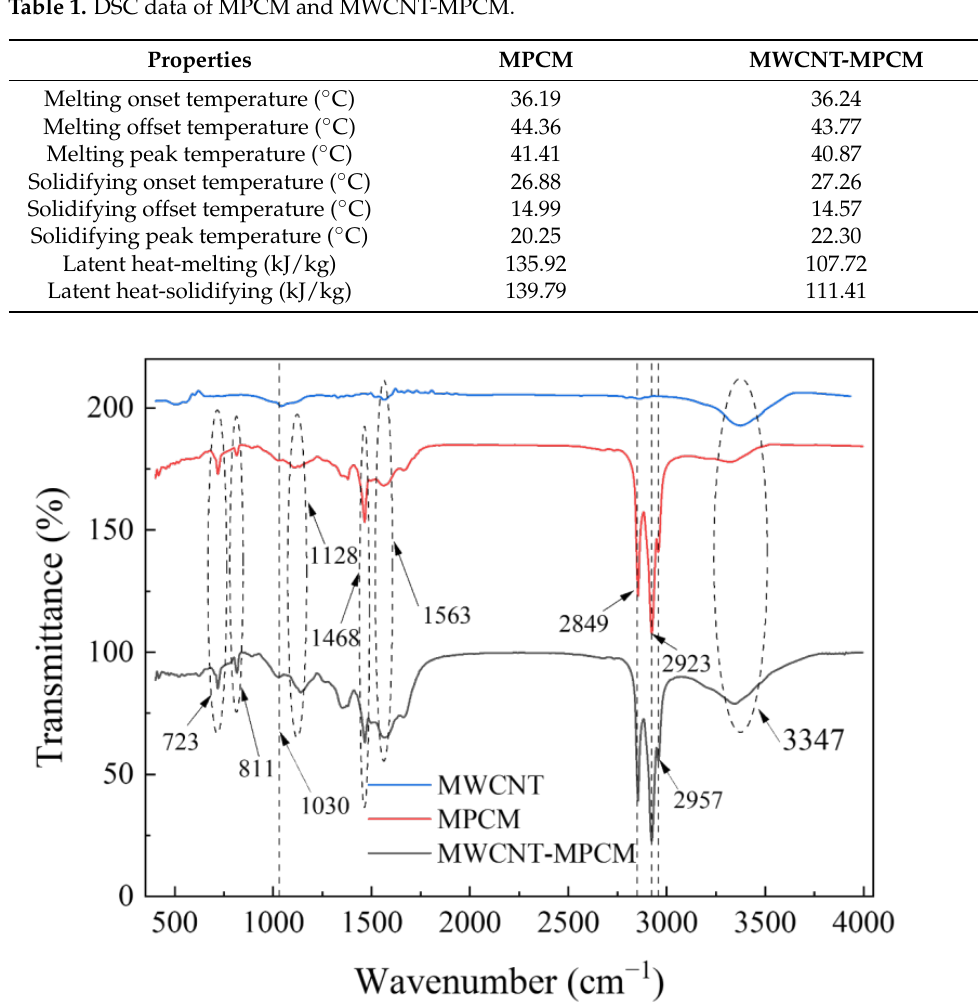
Figure 4. FTIR spectra of MWCNT, MPCM, and MWCNT-MPCM.